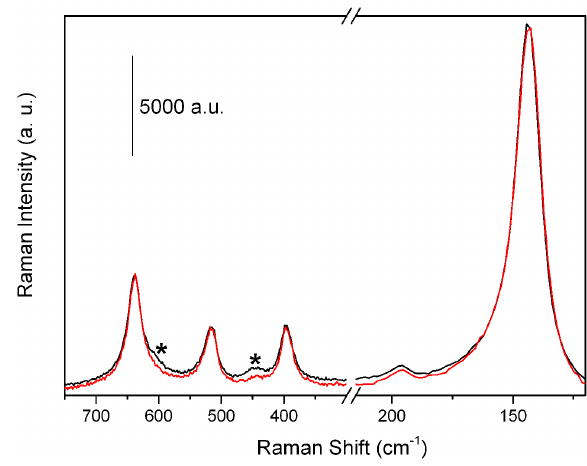
Figure 2. Raman spectra of TiO 2 and S-doped TiO 2 (black and red lines, respectively). Raman fingerprints of rutile are marked by